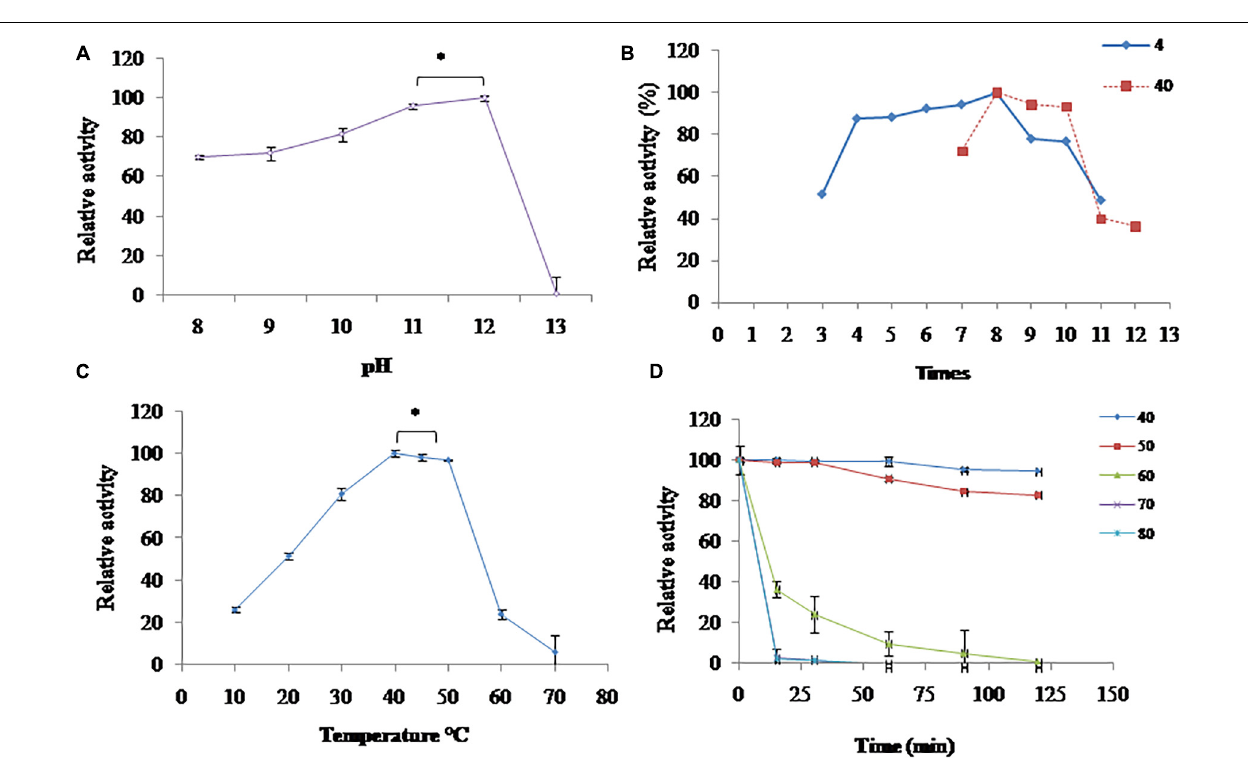
after incubation for 16 h at 4 ◦ C over a wide pH range (4.0–10.0) ( Figure 3B ). When incubated at 40 ◦ C for 1 h, the maximum activity (100%) of the PyCP was observed at pH 8.0, followed by 94 and 93% residual activity at pH 9.0 and 10.0, respectively, whereas, relative activity of 40 and 36% was observed at pH 11.0 and 12.0,